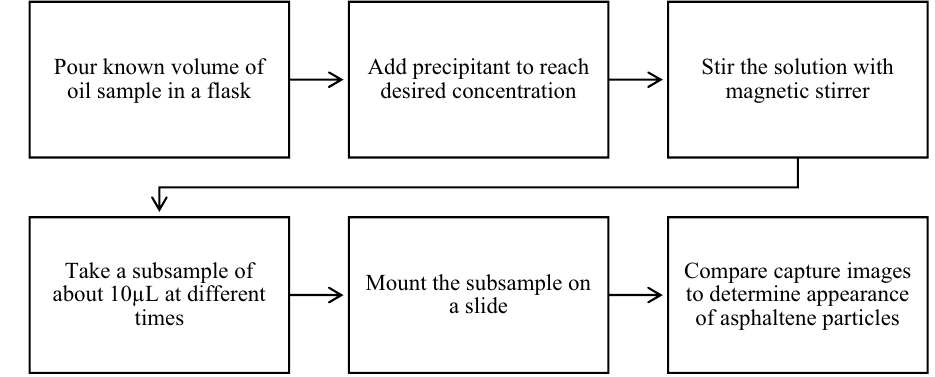
Fig. 7 Procedure for optical microscopy technique (Maqbool